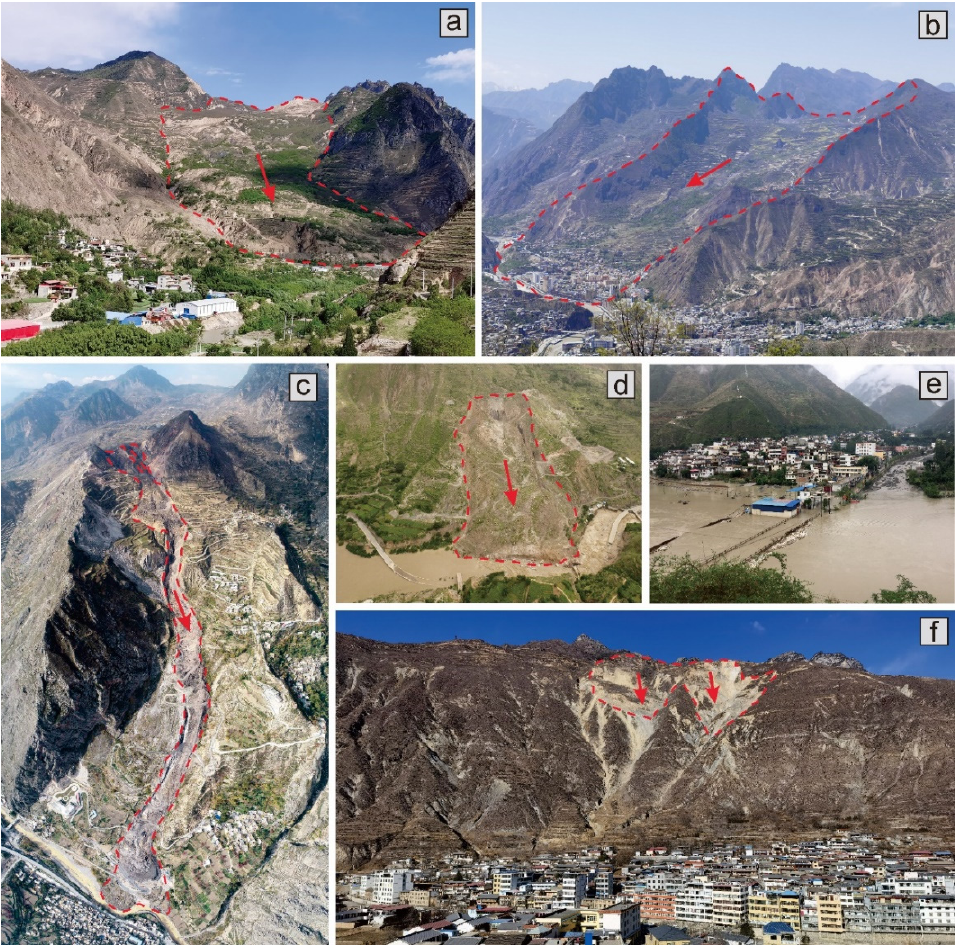
Figure 3. Typical landslides and disaster effects in the study area. ( a ) Xieliupo landslide; ( b ) Suoertou landslide; ( c ) Yahuokou landslide; ( d ) Jiangdingya landslide; ( e ) barrier lake formed by the Jiangdingya landslide; ( f ) Lijie landslide.